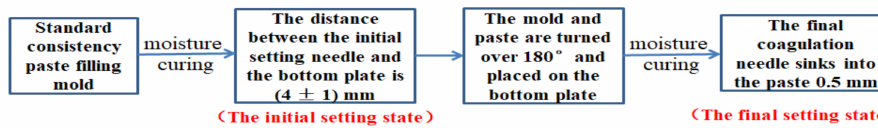
Figure 4. Initial setting state and final setting state.